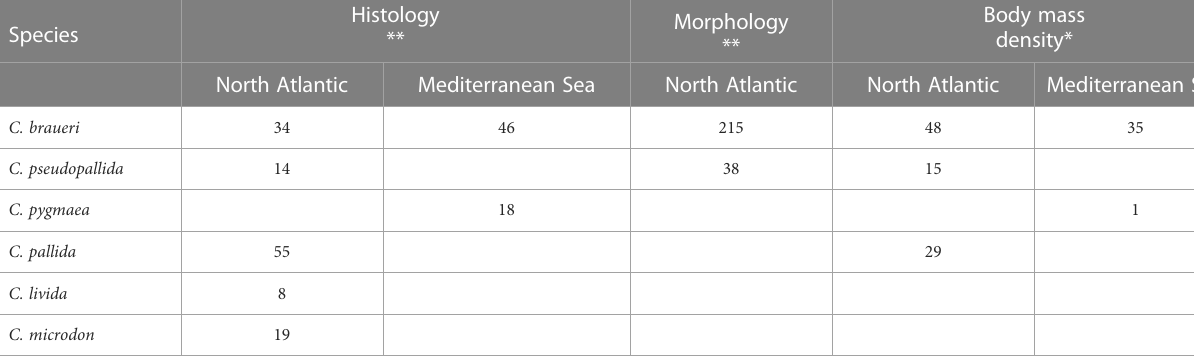
TABLE 1 Number of specimens used in histological analysis, morphological, and body-mass density